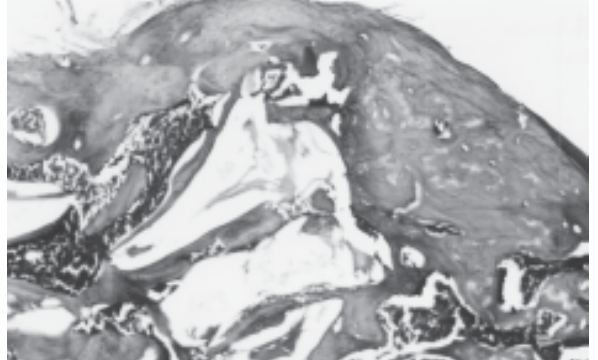
FIGURE 4 - BG 30 days. Bone trabeculae surrounding the spaces taken up by glass particles are thicker and more mature (A), with indications of remodeling, as on defect margins, and interspersed with bone marrow. Thin bone septa are found inside the spaces (B). Fibrilar aspect has also been found in this group. HE. Magnification 100x